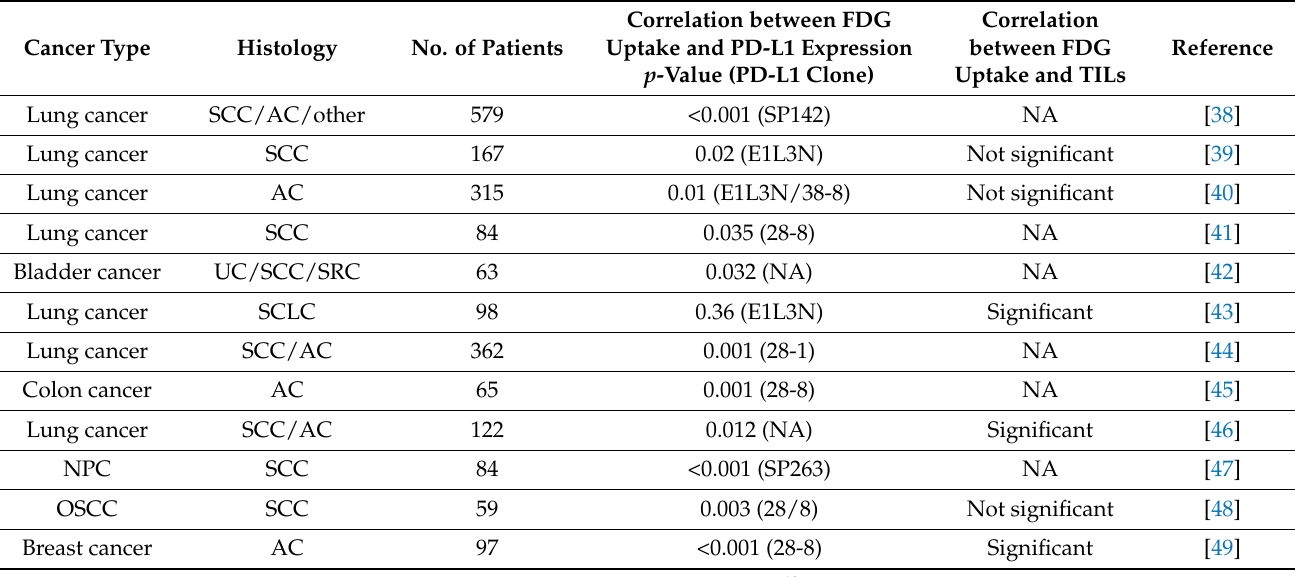
Table 2. Relationship among PD-L1 expression, TILs, and FDG uptake in various cancer